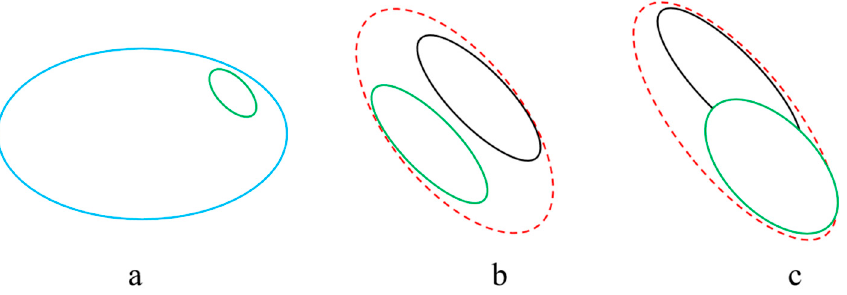
Figure 4. Detection errors for overlapping craters: ( a ) when elliptical craters overlap, it is generally easier to detect only large craters; ( b ) When elliptical craters are close enough, it is generally easy to be mistakenly detected as red ellipse; ( c ) When elliptical craters are partial overlap, it is generally easy to be mistakenly detected as red ellipse;